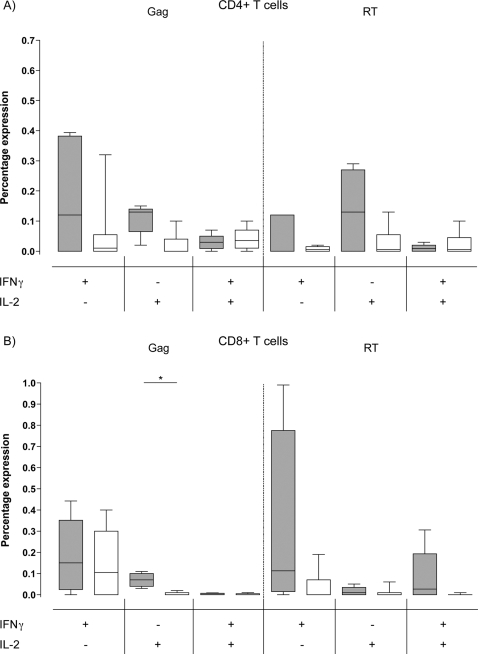
Exposure did not increase poly-functionality.The ability of CD8+ (A) and CD4+ (B) T cells to express IFN-γ and IL-2 was assessed in both the VP group (shaded boxes, n = 5) and NVP group (open boxes, n = 8). Poly-functionality was determined by the expression of both cytokines. Only the percentage of IL-2 expressing CD8+ T cells was significantly higher in the VP group (p = 0.0059), denoted by *.